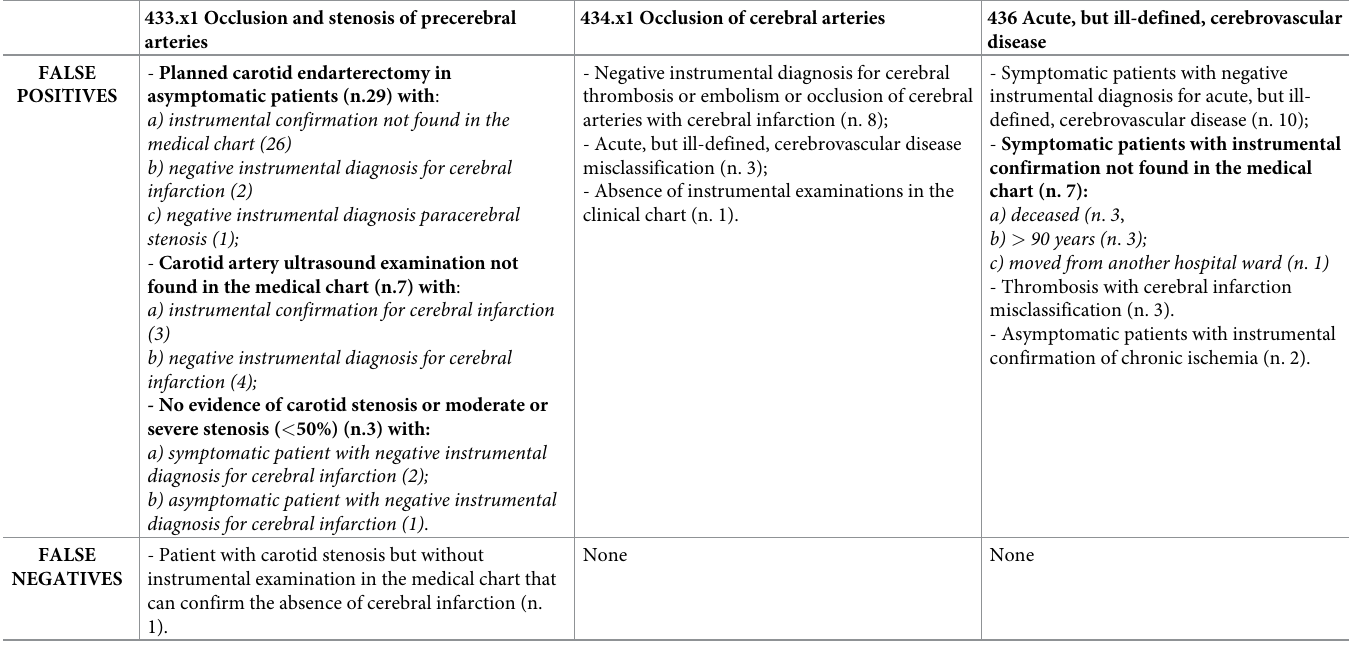
Table 10. Ischemic stroke: reasons for incorrect identification of cases and controls.